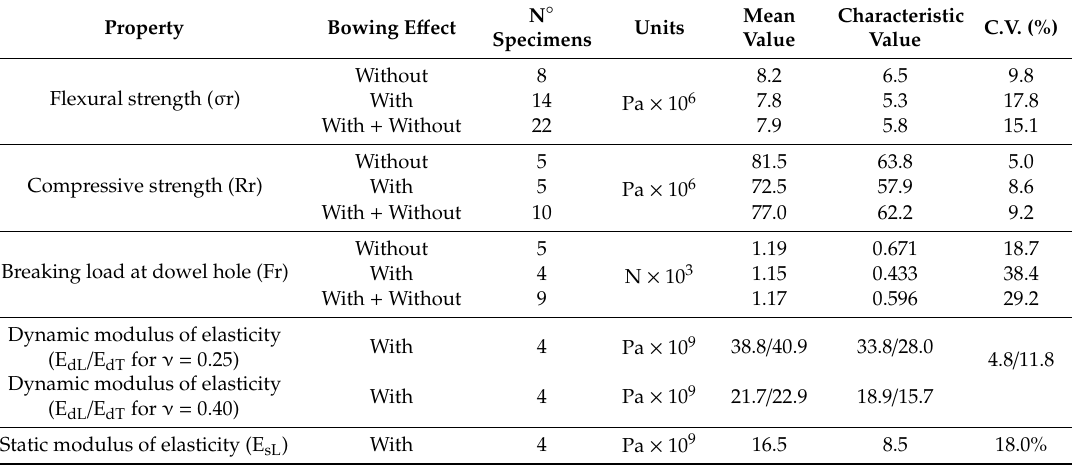
Table 1. Test results obtained from marble stone